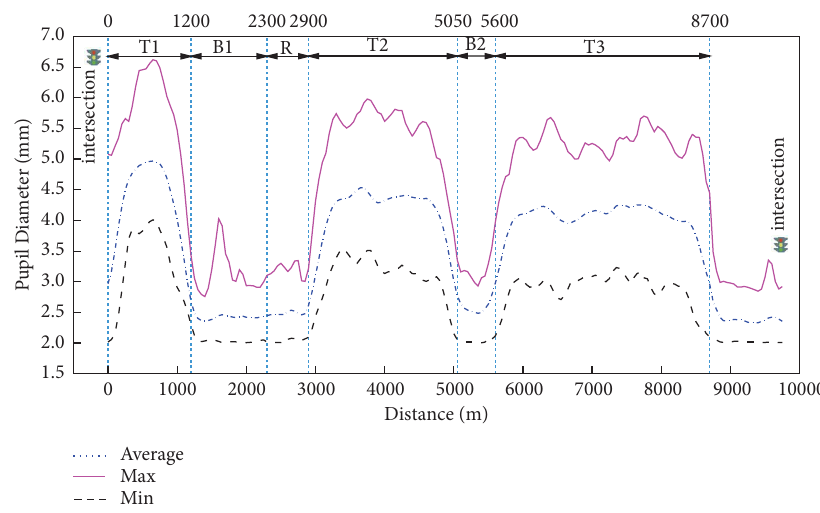
Figure 4: Te daytime pupil diameter varies with distance.